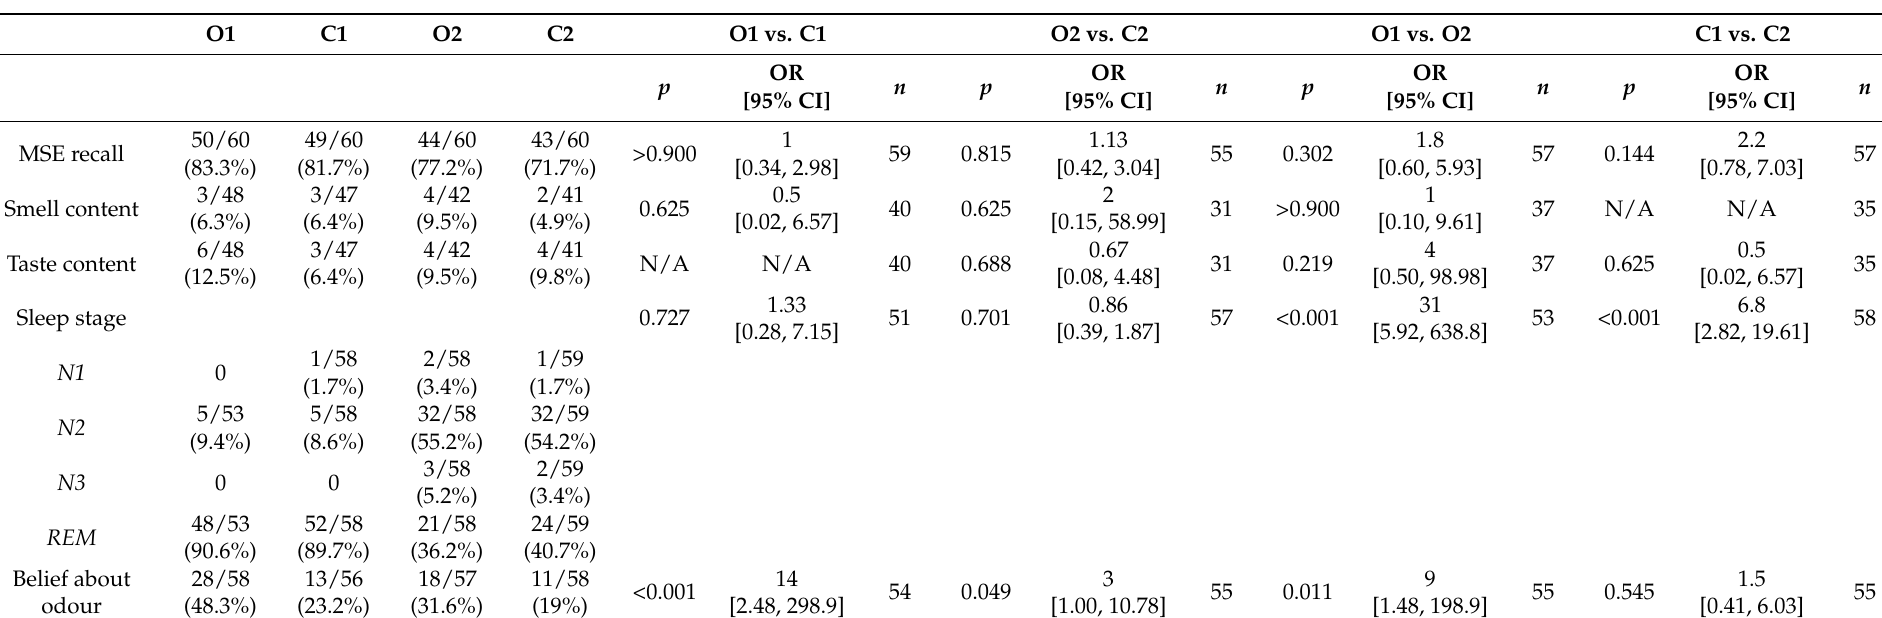
Table 2. Absolute and relative frequencies for mental sleep experience (MSE) recall (yes/no), olfactory and gustatory content (present/absent) in the sample without the two outliers, sleep stage (REM vs. NREM), and belief about odour presence (present/absent). O1 and C1 refer to the first awakening in the odour and control condition, respectively, and O2 and C2 to